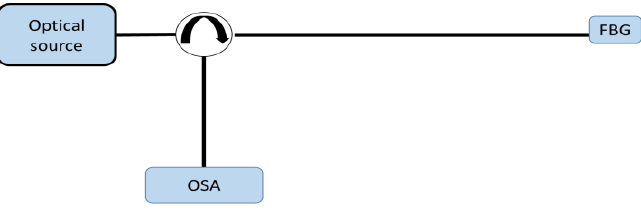
Figure 12. Simple interrogation set up: a broadband optical source is connected to a circulator to feed the FBG, while the FBG reflected beam is redirected to a conventional optical spectrum analyser (OSA) through a circulator.